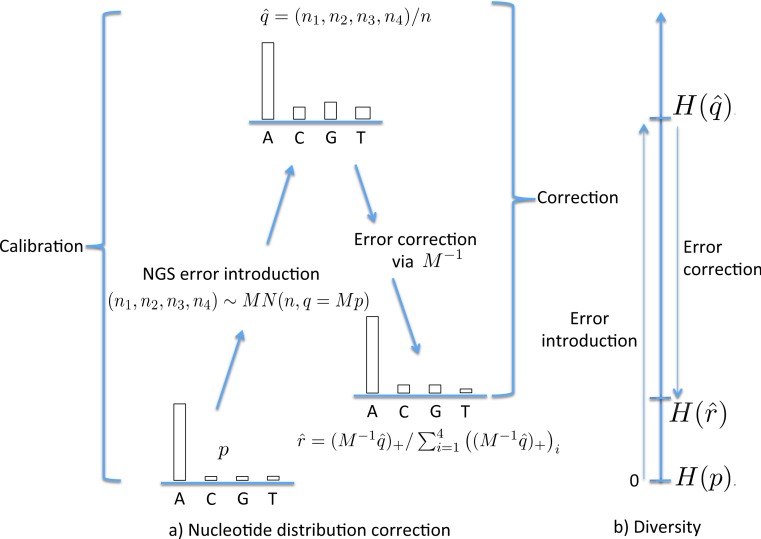
The stages of NGS nucleotide distribution error correction.(A) Error is introduced to the true nucleotide distribution p, giving distribution \documentclass[12pt]{minimal}
\usepackage{amsmath}
\usepackage{wasysym}
\usepackage{amsfonts}
\usepackage{amssymb}
\usepackage{amsbsy}
\usepackage{upgreek}
\usepackage{mathrsfs}
\setlength{\oddsidemargin}{-69pt}
\begin{document}
}{}$\hat {q}$\end{document}qˆ, the result of multinomial sampling with n (the coverage, the number of nucleotides sequenced) trials in which the true sequenced nucleotide distribution is given by q = Mp. The error is corrected by forming \documentclass[12pt]{minimal}
\usepackage{amsmath}
\usepackage{wasysym}
\usepackage{amsfonts}
\usepackage{amssymb}
\usepackage{amsbsy}
\usepackage{upgreek}
\usepackage{mathrsfs}
\setlength{\oddsidemargin}{-69pt}
\begin{document}
}{}$\hat {r}$\end{document}rˆ, the normalisation of \documentclass[12pt]{minimal}
\usepackage{amsmath}
\usepackage{wasysym}
\usepackage{amsfonts}
\usepackage{amssymb}
\usepackage{amsbsy}
\usepackage{upgreek}
\usepackage{mathrsfs}
\setlength{\oddsidemargin}{-69pt}
\begin{document}
}{}$({M}^{-1}\hat {q})_{+}$\end{document}M−1qˆ+. In practice M must be estimated (the calibration step), using a known initial distribution p. (B) The initial diversity H(p) increases to \documentclass[12pt]{minimal}
\usepackage{amsmath}
\usepackage{wasysym}
\usepackage{amsfonts}
\usepackage{amssymb}
\usepackage{amsbsy}
\usepackage{upgreek}
\usepackage{mathrsfs}
\setlength{\oddsidemargin}{-69pt}
\begin{document}
}{}$H(\hat {q})$\end{document}Hqˆ under NGS, but falls back to \documentclass[12pt]{minimal}
\usepackage{amsmath}
\usepackage{wasysym}
\usepackage{amsfonts}
\usepackage{amssymb}
\usepackage{amsbsy}
\usepackage{upgreek}
\usepackage{mathrsfs}
\setlength{\oddsidemargin}{-69pt}
\begin{document}
}{}$H(\hat {r})$\end{document}Hrˆ when corrected.